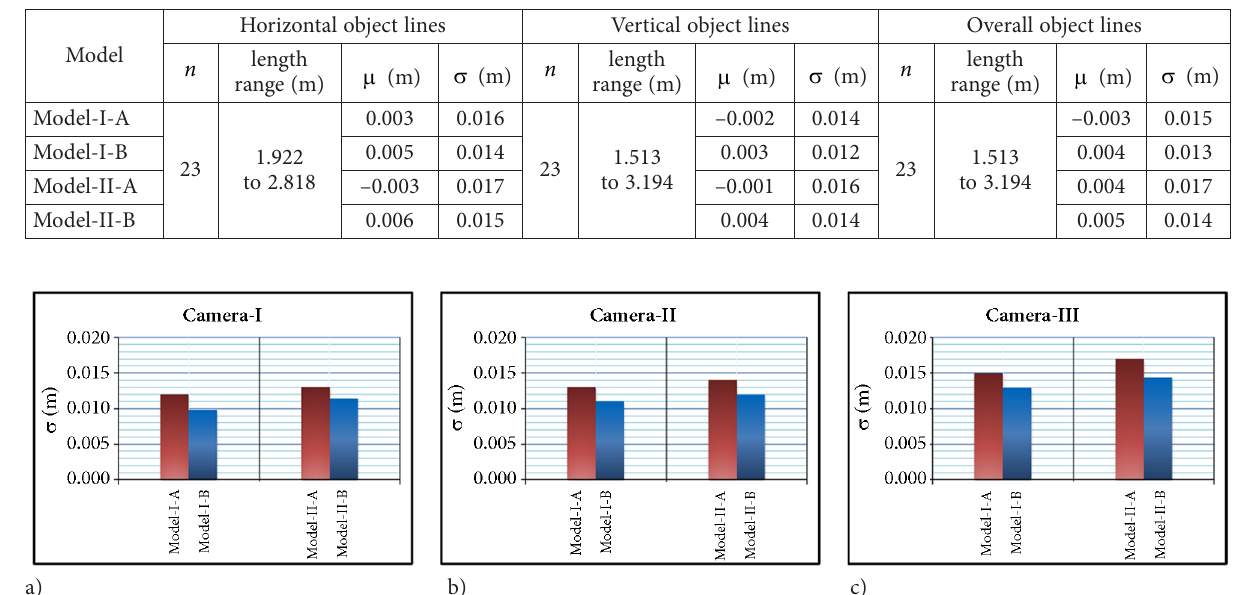
Table 8. Results for Camera-III